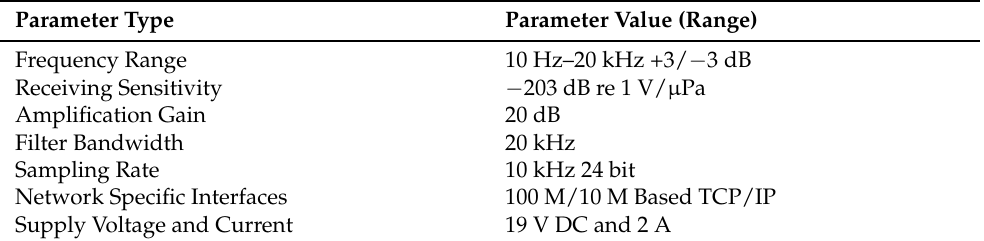
Figure 14. Hydrophone: signal conditioning, low-noise cable and data acquisition. Table 1. Hydrophone